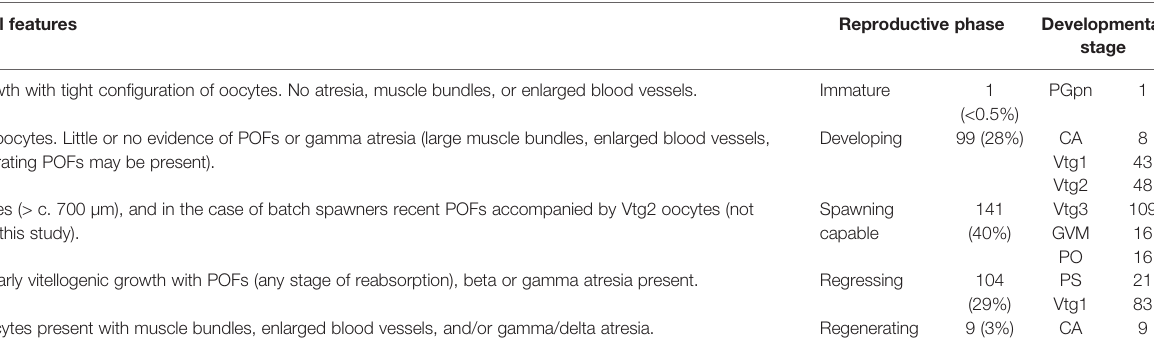
TABLE 1 | Description of the histological features of reproductive phases for large (83-180 cm) female Paci fi c halibut (modi fi ed from Brown-Peterson et al., 2011), total fi sh observed from each phase (percent shown in parentheses), and a summary of total fi sh observed in corresponding developmental stages (see Fish et al., 2020 for detailed stage